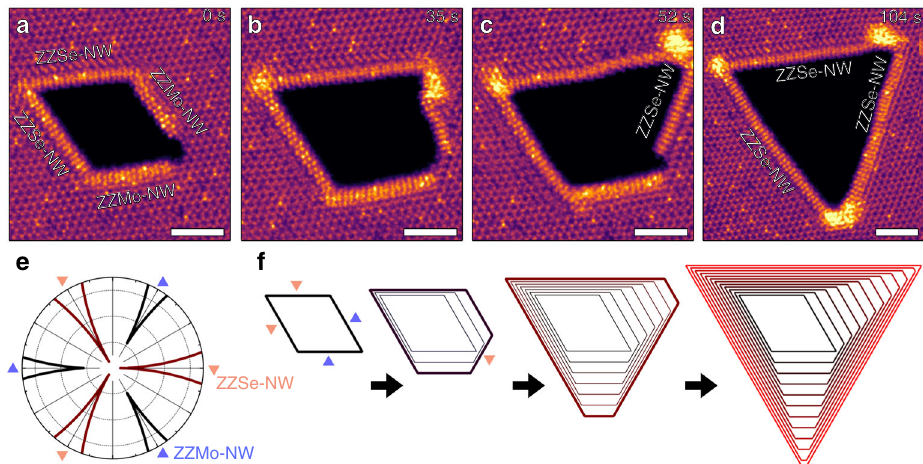
Fig. 4 Shape evolution of an etched pore with all edges terminated by NWs. a – d Atomic resolution HAADF-STEM images showing the shape evolution of an initial NW-terminated parallelogram pore. e Polar plot of etching rates of NW-terminated ZZSe and ZZMo edge. ZZSe-NW (brown) etches more slowly than ZZMo-NW (black). f Simulated etching progress of the NW-terminated parallelogram pore shown in a . Scale bars are 2 nm